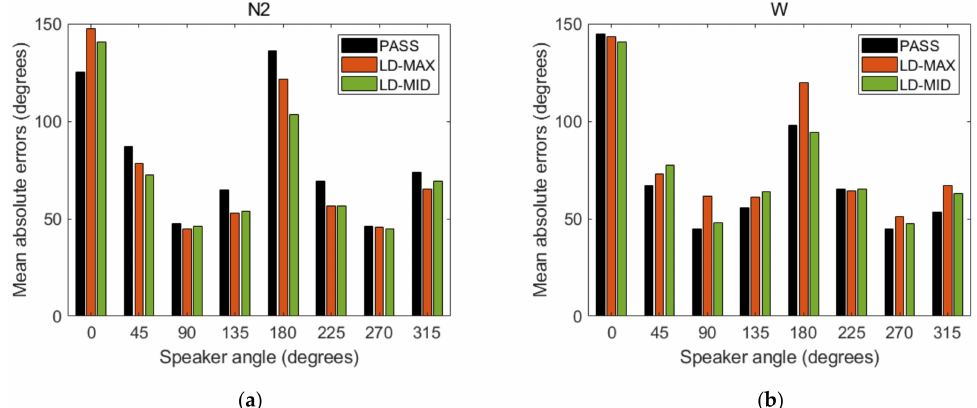
Figure 5. Mean absolute errors calculated for the indications given by users of the N2 earmuffs ( a ); and W earplugs ( b ). PASS—with the level-dependent system switched off.